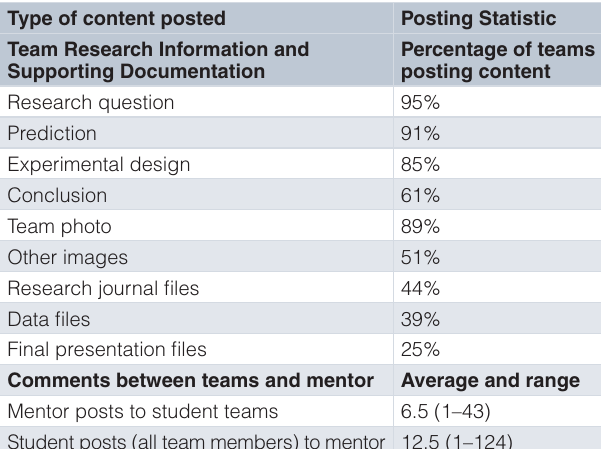
Table 1. Summary of types of content posted on the student teams’ online project